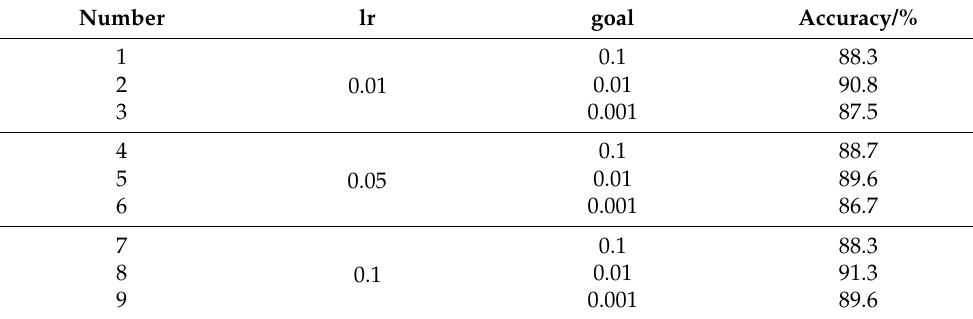
Table 13. BPNN driving propensity identification